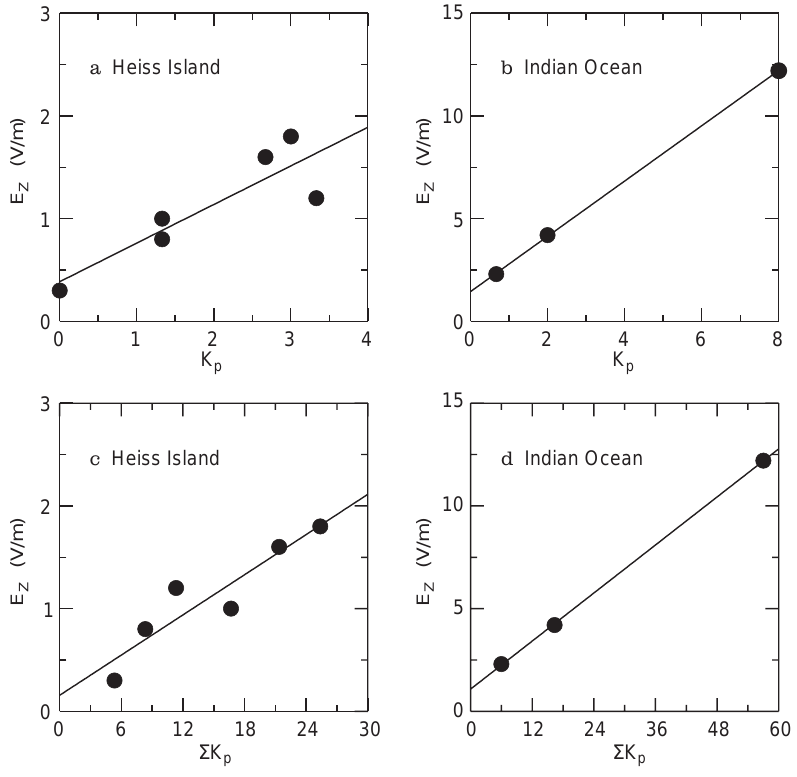
Fig. 5. The maximum absolute value of the vertical electric field measured in the mesosphere as a function of the geomagnetic index a, b K p P and c, d K